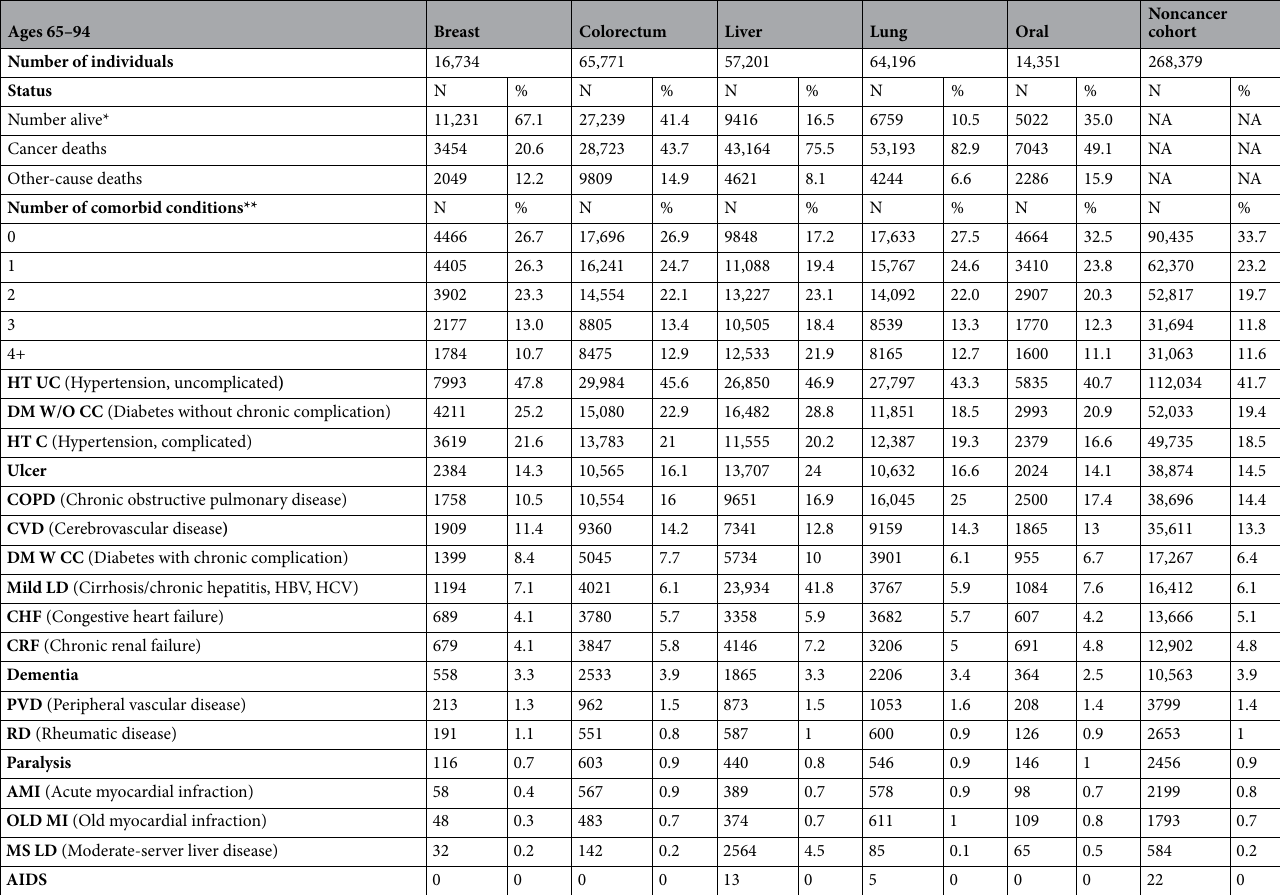
Table 1. The prevalence of selected comorbidities for the 5 most common cancers in Taiwan diagnosed in 2004–2014 and for individuals without cancer sampled in 2004–2014, ages 65–94. *Death due to the cancer or other causes was decided by the SEER (NCI) classification algorithm using the TCOD and TCR from 2004 until Dec. 31, 2016; survival information of patients not included in the TCOD were obtained from the beneficiary registry of NHIRD at Dec. 31, 2015; the latter were all considered alive. **The percentage is calculated by deleting the cells whose case number < 5. The 11 most common comorbidities for these 5 cancers in the order of their numbers are: HT UC (98,458), DM W/O CC (50,617), HT C (43,723), COPD (40,508), Ulcer (39,312), Mild LD (34,000), CVD (29,634), DM W CC (17,034), CRF (12,569), CHF (12,116) and Dementia